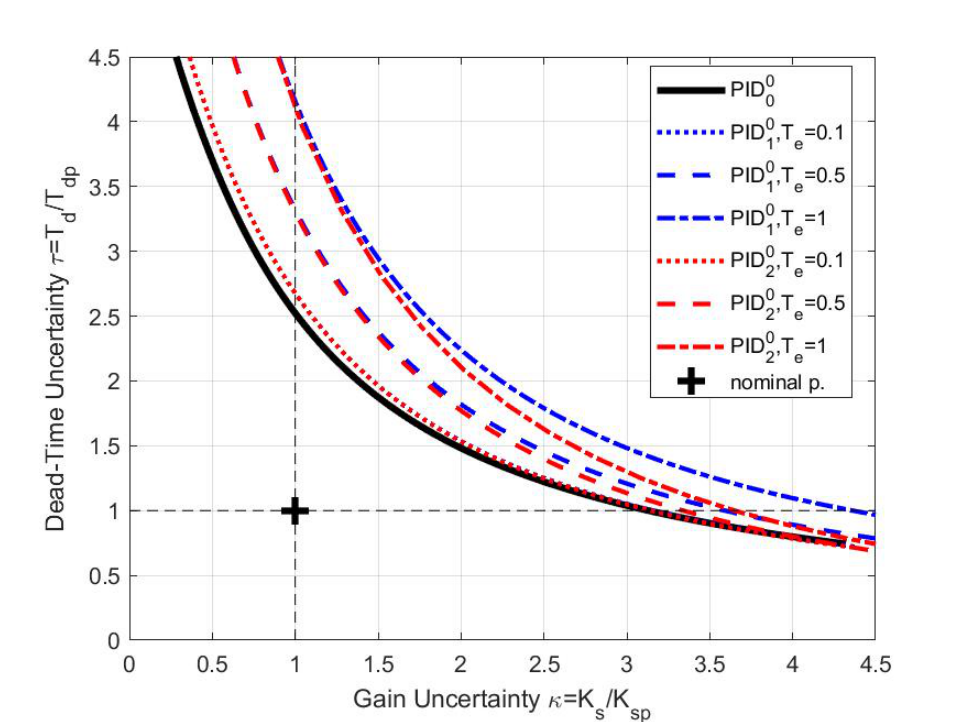
and filtered PID 0 and PID 0 control for several 0 2 1